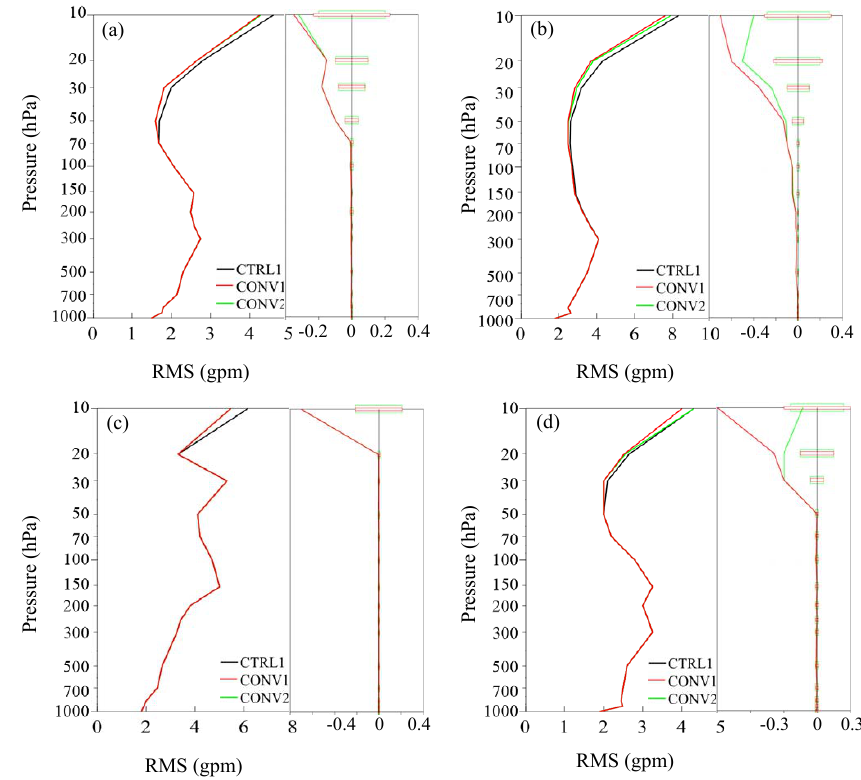
Figure 13. Same to Fig. 12 but for RMS of U